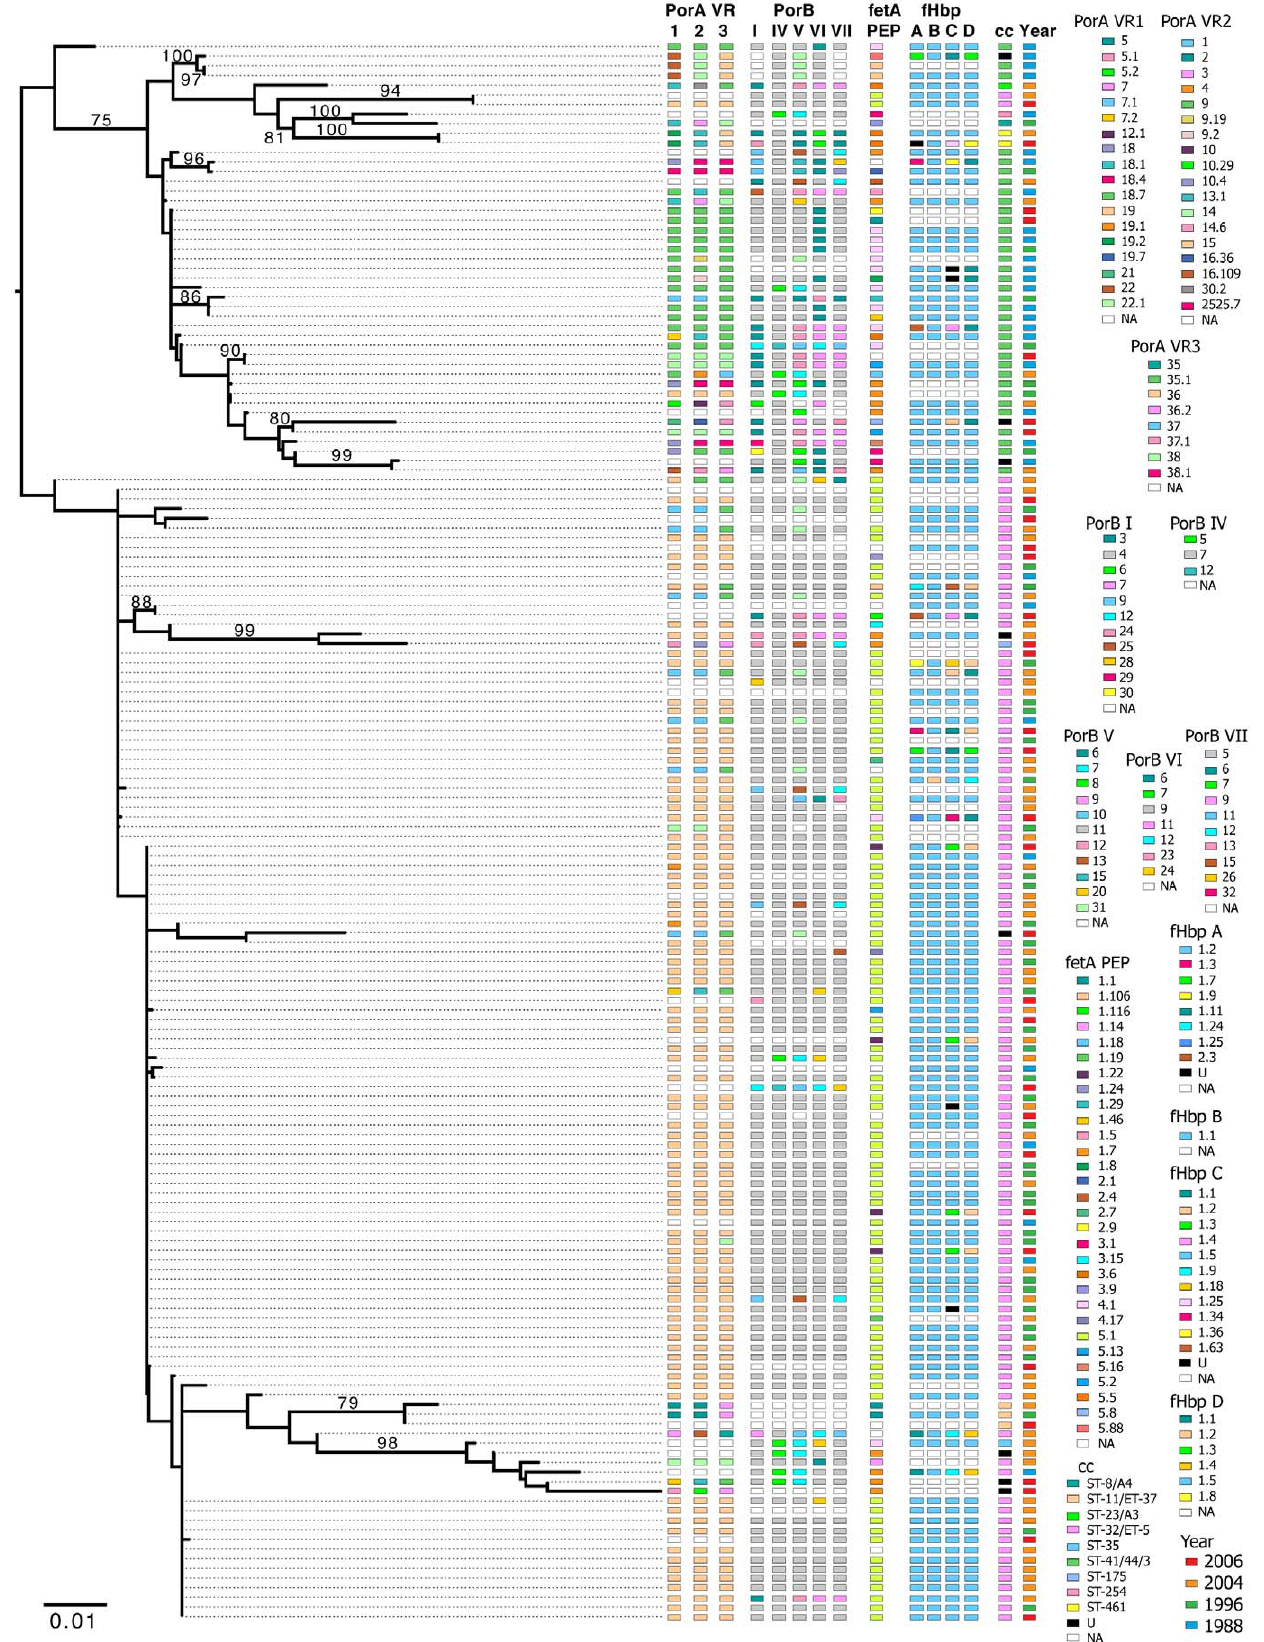
Figure 3. Maximum-likelihoodphylogenyof the MLST DNA sequencesfromSa˜oPaulo. Annotations are for OMPtheneisseria.org (http://pubmlst. org/ neisseria.org/) (PorA, PorB, FetA, and FHbp, respectively), clonal complex, and year of collection. Numbers above the branches are bootstrap percentages. doi:10.1371/journal.pone.0033016.g003 PLoS ONE |